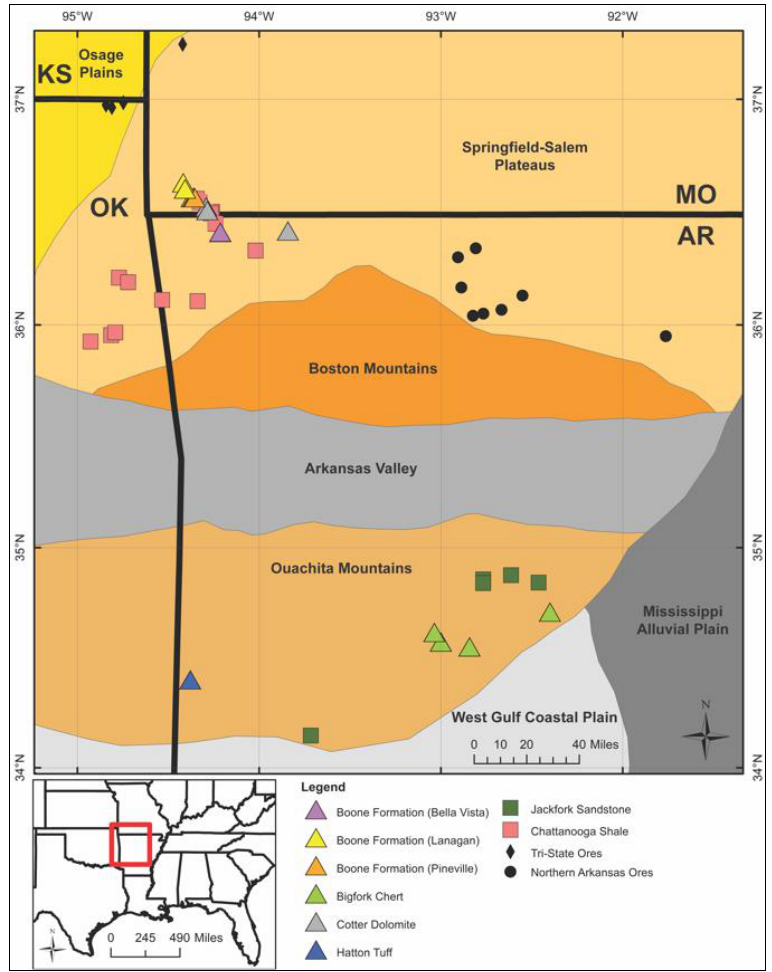
Figure 2. Location of samples analyzed in this study (triangles) and those of previous studies: squares [9,10], diamonds [9,28], and circles [9,28]. Modified from [10].